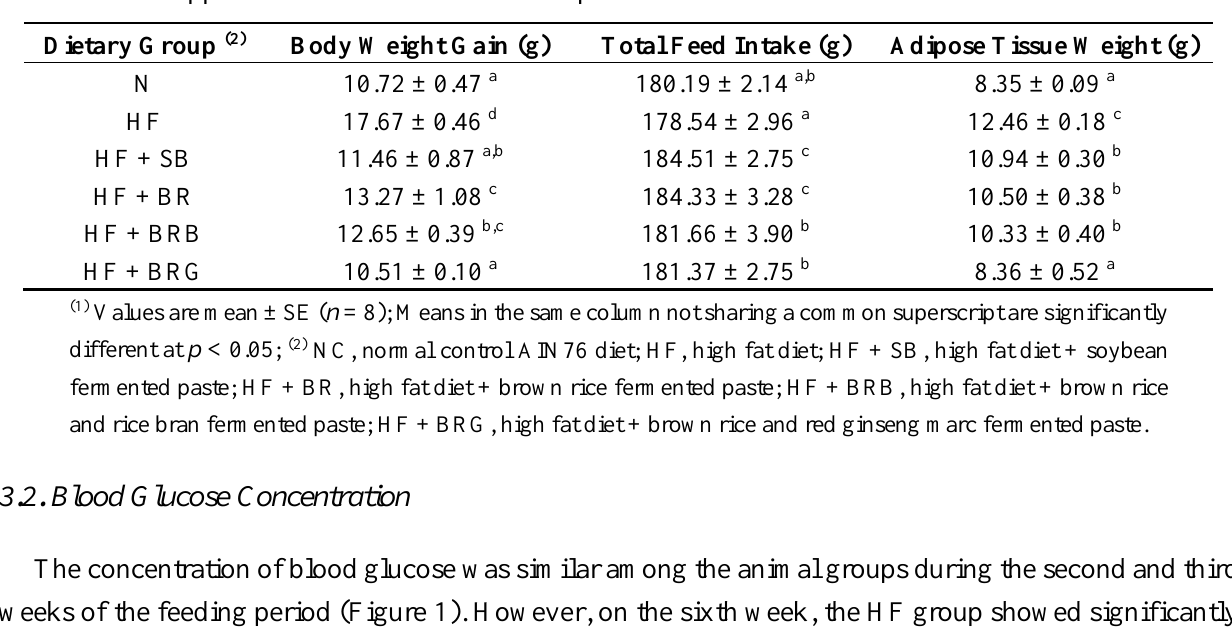
Table 3. Body weight gain, feed intake, and adipose tissue weight (1) in mice fed with high fat diet supplemented with rice fermented